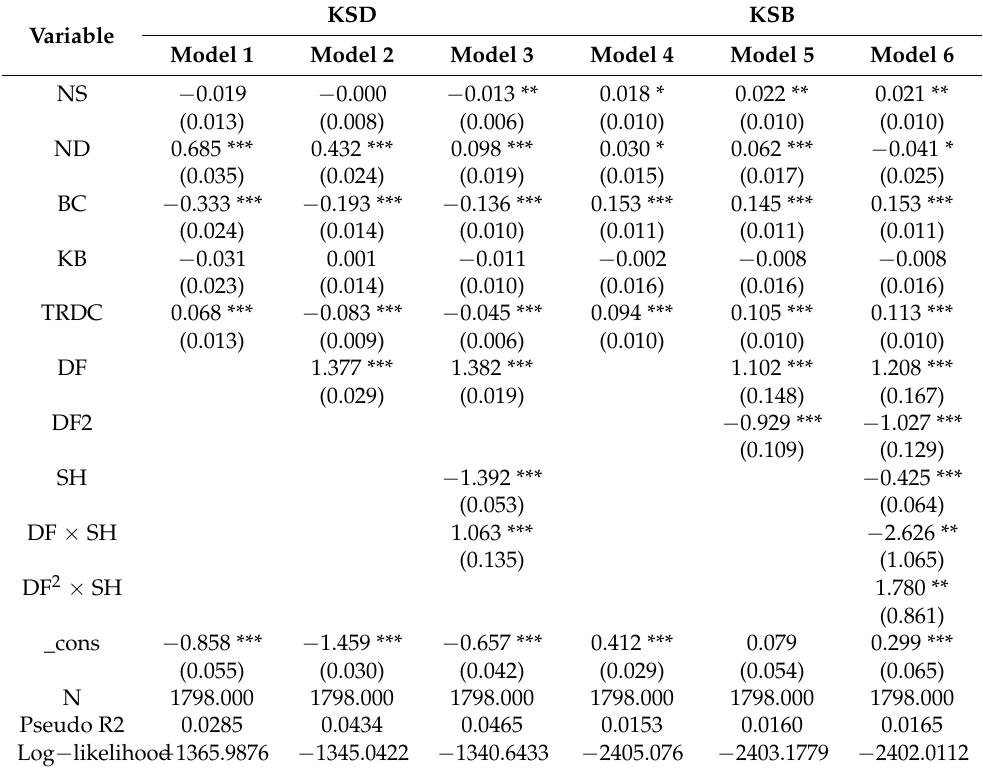
Table 4. Results of the robustness